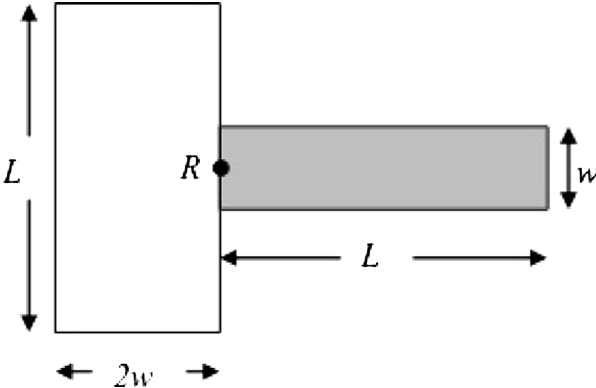
FIG. 5. Figure used in the T -shaped object task. Dimensions are given on the diagram. Students were told that the density of the shaded part is twice that of the unshaded part. They were asked if the center of mass of the object is located to the left of, to the right of, or at point R